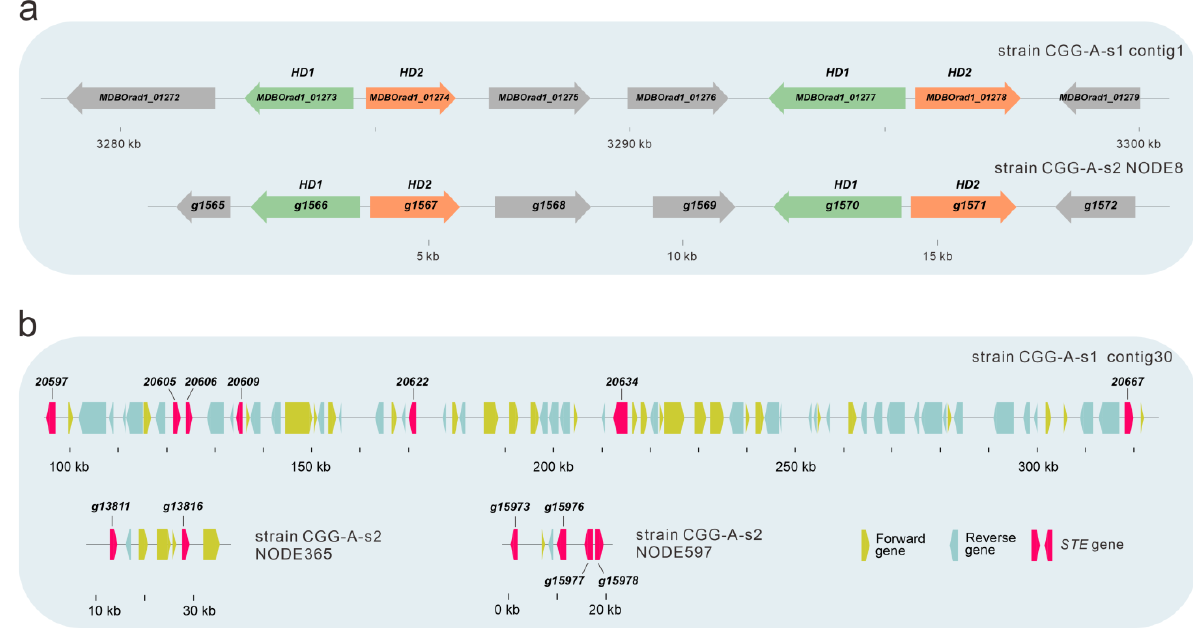
Figure 6. Gene structure of the mating type locus of in O. raphanipes CGG-A-s1 and CGG-A-s2. ( a ) Structure of A mating type locus in O. raphanipes . ( b ) Structure of B mating type locus in O. raphanipes .